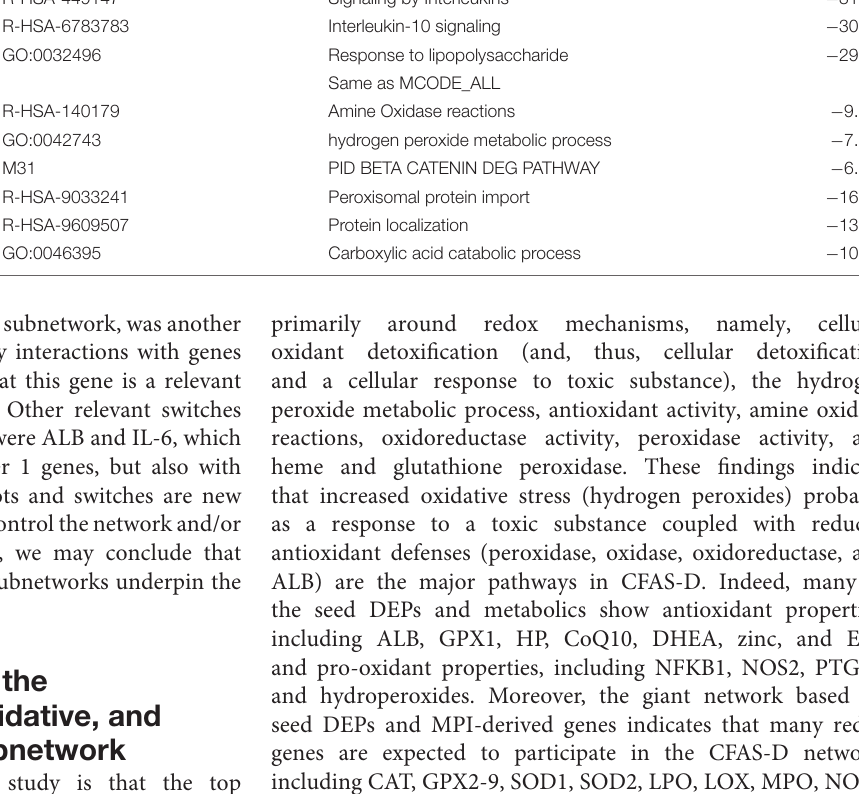
TABLE 3 | Results of molecular complex detection (MCODE) analysis performed on the differently expressed proteins (DEPs) of chronic fatigue spectrum disorders. MCODE